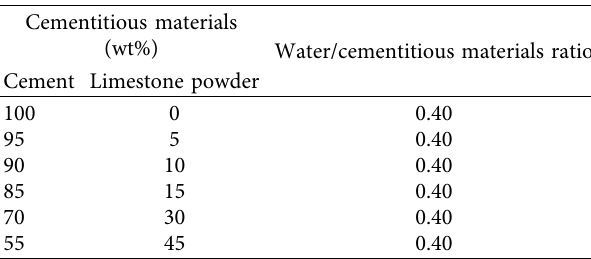
Table 2: Mixture proportions of the cement paste. Cementitious materials